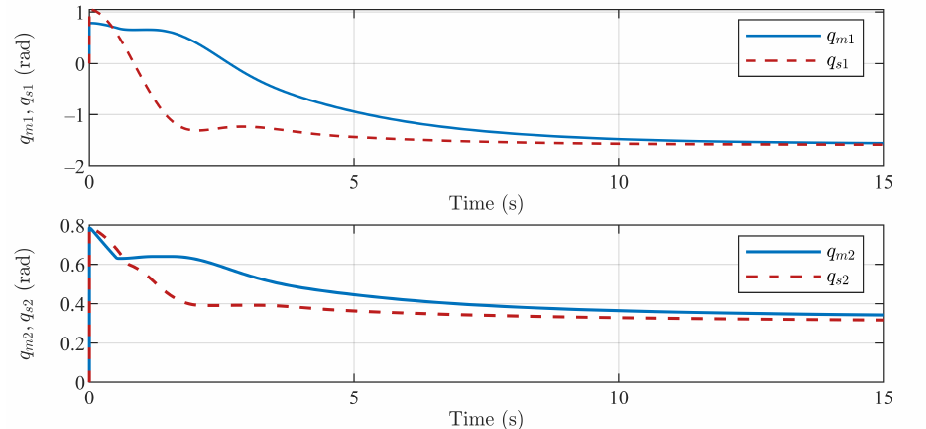
Figure 13. Joint positions of the master and slave end-effectors with the method in Case